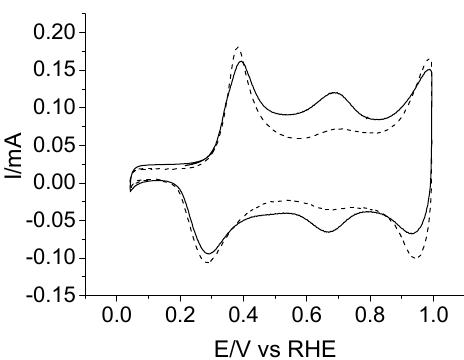
Figure 4. Electrochemical response in 1 M of HClO 4 medium of a Pt electrode covered with either polyaniline (dashed line) or an aniline–piperazine copolymer (solid line), which were deposited under the potential program used in Figure 3. v = 50 mV s − 1.